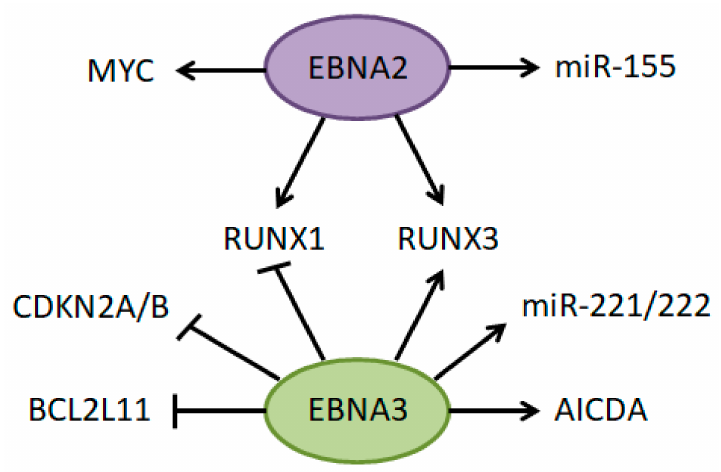
Figure 4. Enhancer hijacking by Epstein–Barr virus. Presented are interactions of Epstein–Barr Virus Nuclear Antigen 2 and 3 (EBNA2 and EBNA3) proteins with host gene enhancers. Arrows indicate activation of gene expression; bars represent